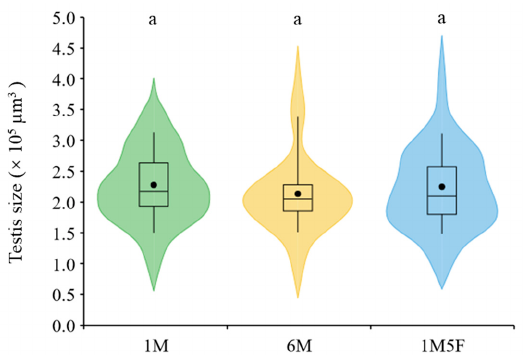
Figure 3. Effect of socio-sexual environment during the pupal stage on testis size of E. kuehniella . 1M, one male; 6M, six males together; 1M5F, one male and five females together. Each box plot shows the range between the first and third quartiles (black box), mean (black dot) and median scores (black lines); and ‘violin’ shapes show the shape of the distribution. The same letters on the top of the shapes denote no significant differences between treatments ( p > 0.05).